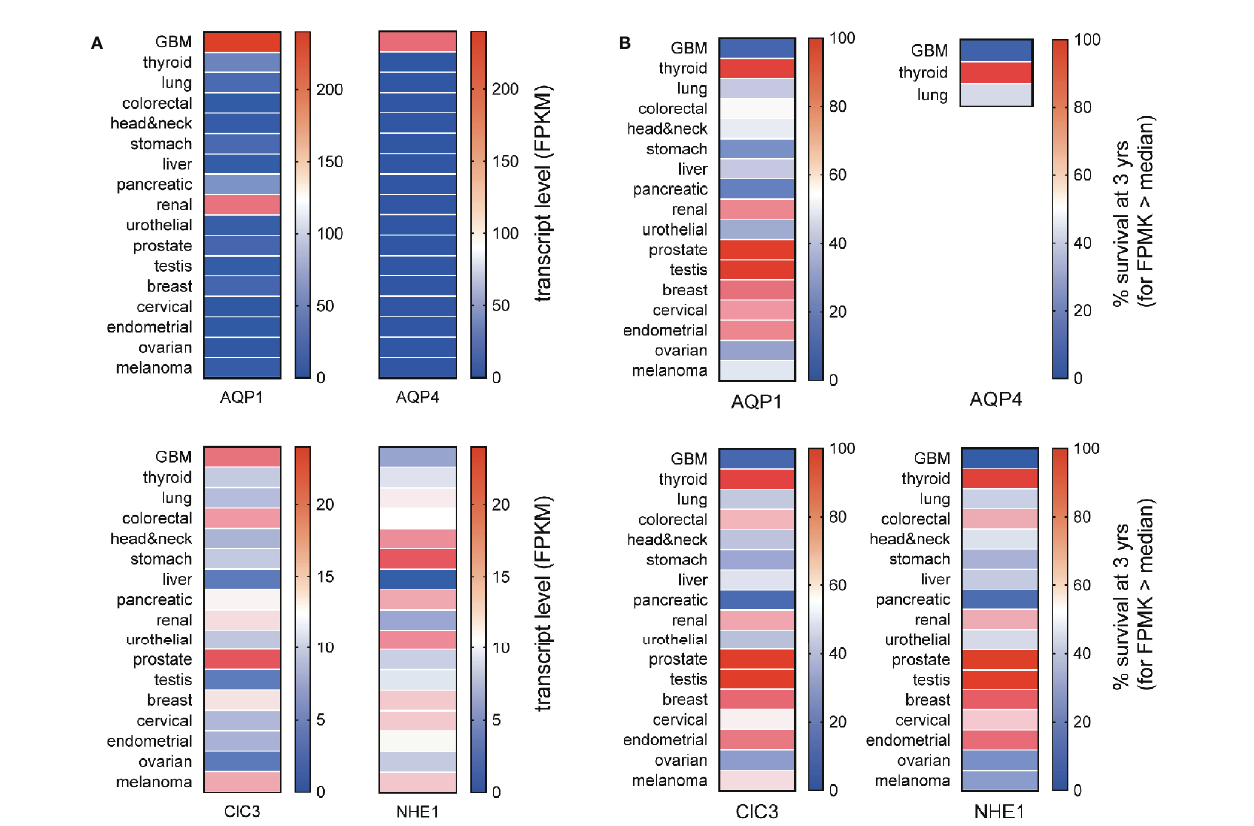
FIGURE 3 | Comparison of transcript levels across different cancers. (A) Heat map comparison of median transcript levels (FPMK, color bars) across a panel of different cancers. (B) Heat map comparison of patient survival at 3 years (%, color bars) across a panel of different cancers. Results were calculated from TCGA data available in the Human Protein Atlas. TCGA, The Cancer Genome